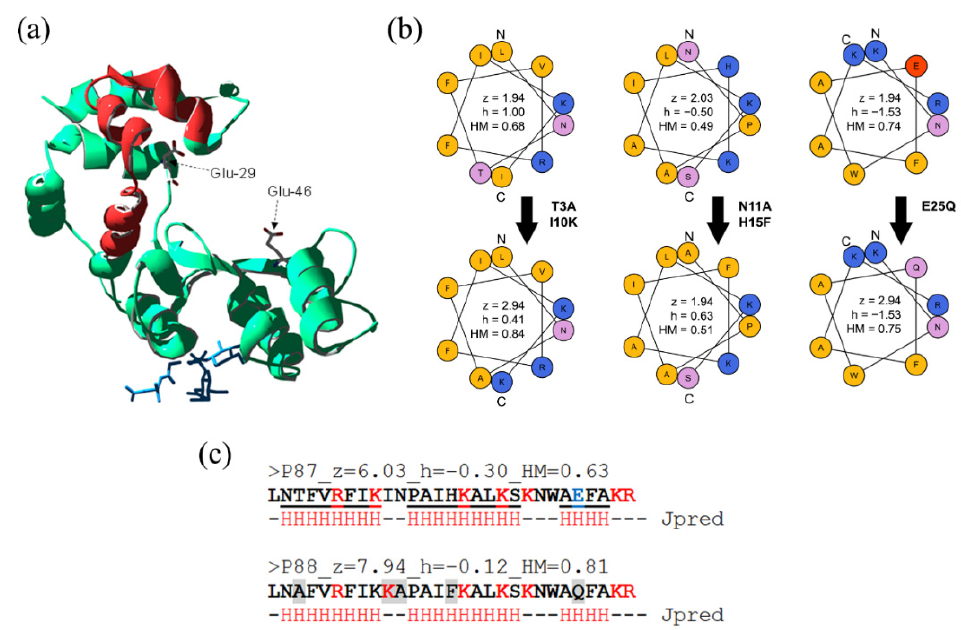
Figure 1. Design of peptide P88. ( a ) Cristal structure of Pae87 [16] (PDB 7Q4T). Peptide P87 is highlighted in red; a bound peptidoglycan fragment (blue) and two catalytic residues (Glu-29 and Glu-46) are presented as spatial references. ( b ) Wheel representation of the three possible α -helices of P87 and the derivative P88. The five P88 modifications with respect to P87 are displayed, as well as the net charge (z), hydrophobicity (h), and hydrophobic moment (HM) calculated for each of the helices. ( c ) P87 and P88 sequences, together with the full sequence net charge, hydrophobicity and HM values, and the JPred secondary structure prediction (a residue marked with an “H” indicates that it is involved in an α -helix). Residues shaded in grey are those mutated in P88.